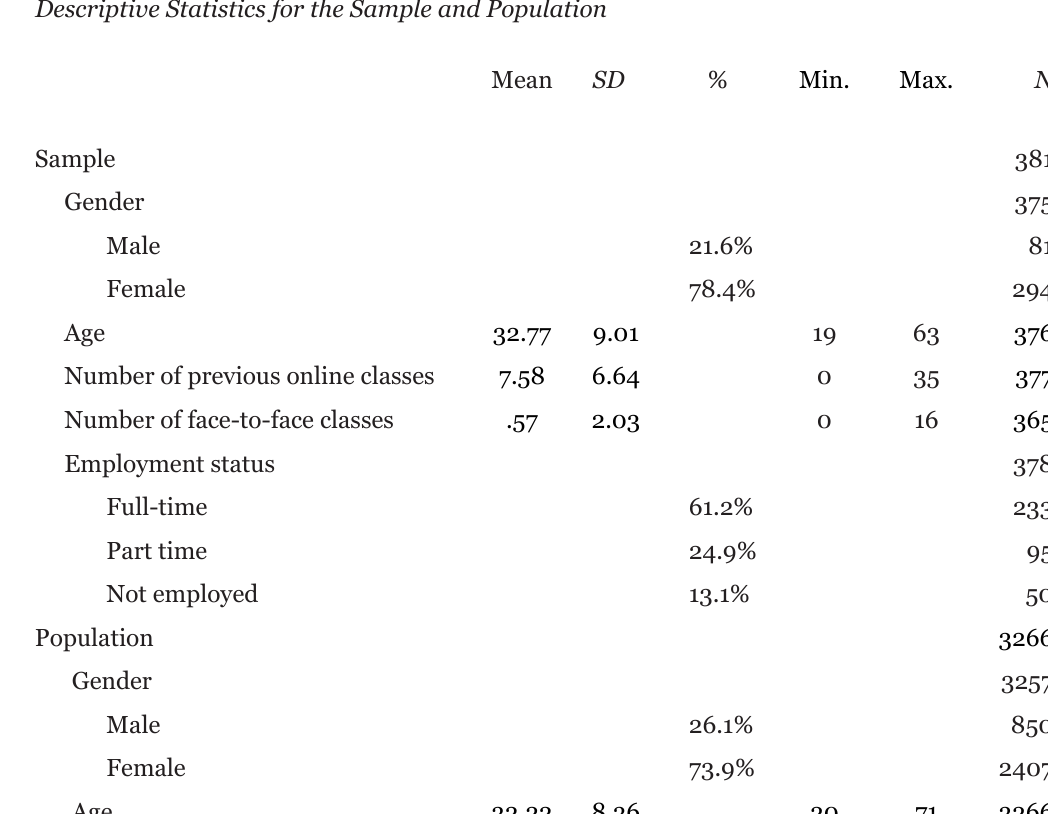
Descriptive Statistics for the Sample and